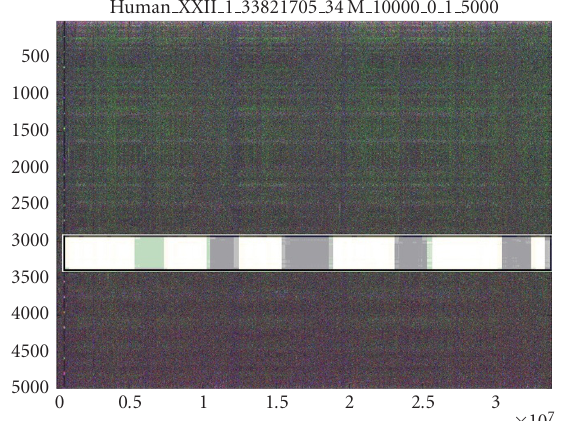
Figure 12: Spectrogram of human chromosome 22 matched up with a part of the Giemsa-stained schematic of the same chromo- some. There is a visual agreement between AT-rich regions and dark bands of Giemsa staining.